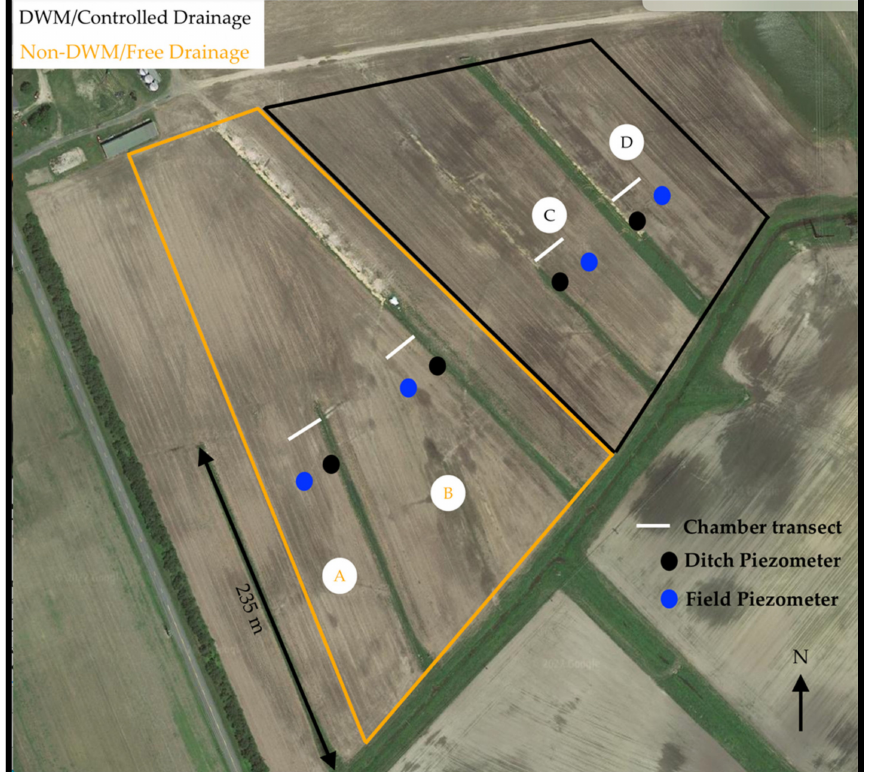
Figure 1. Aerial image of the research site showing the approximate piezometer locations, chamber transect locations, and treatment area borders. Fields A and B were free draining (non-DWM); fields C and D had controlled drainage